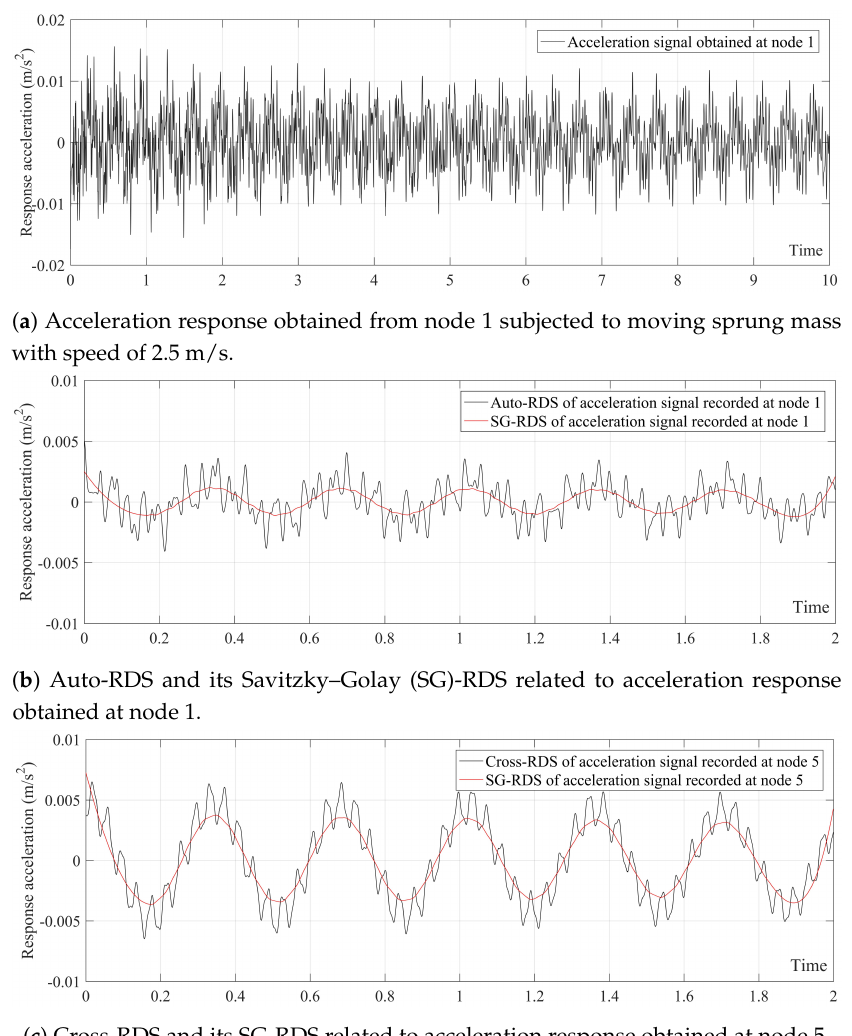
Figure 6. ( a ) Acceleration response recorded at node 1 subjected to moving sprung mass with speed of 2.5 m/s; ( b , c ) are the auto- and cross-RDSs with their corresponding